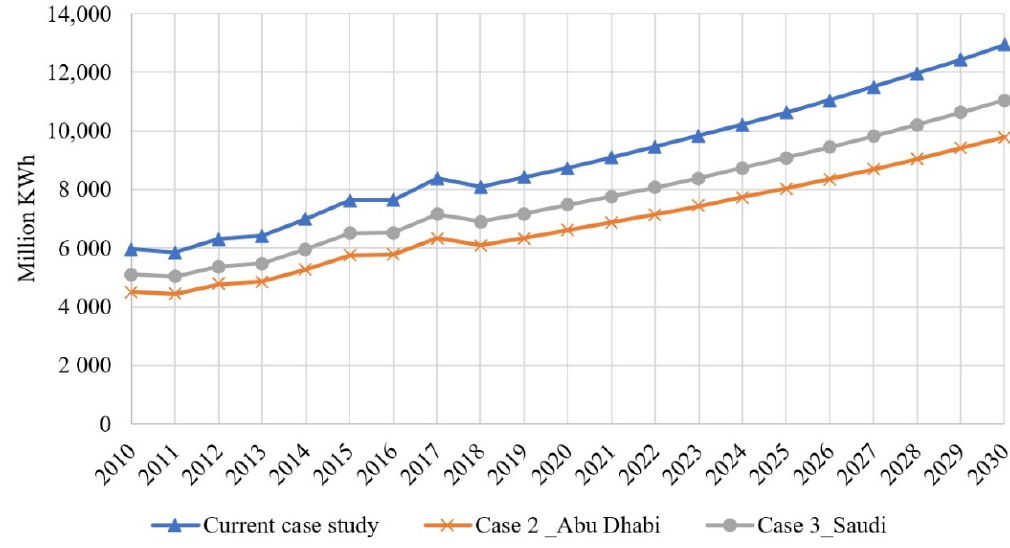
Figure 9. Forecast energy consumption of the residential sector for the promising design scenarios up to 2030.